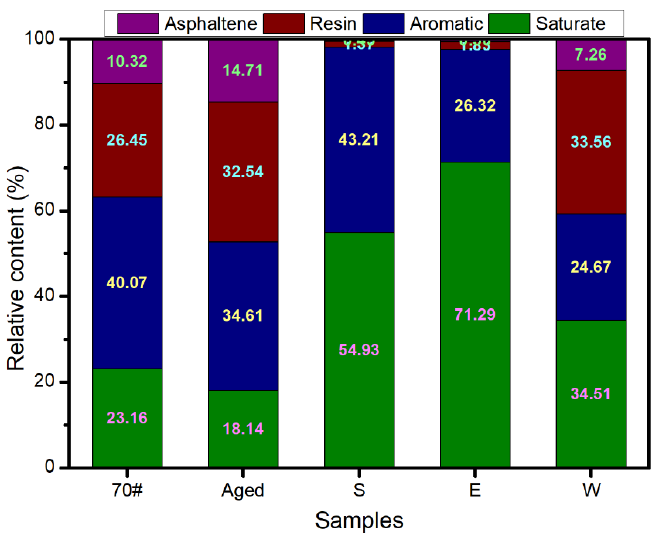
Figure 11. Relative content of the four components of the virgin asphalt (70#), aging asphalt, and the three kinds of healing agents.